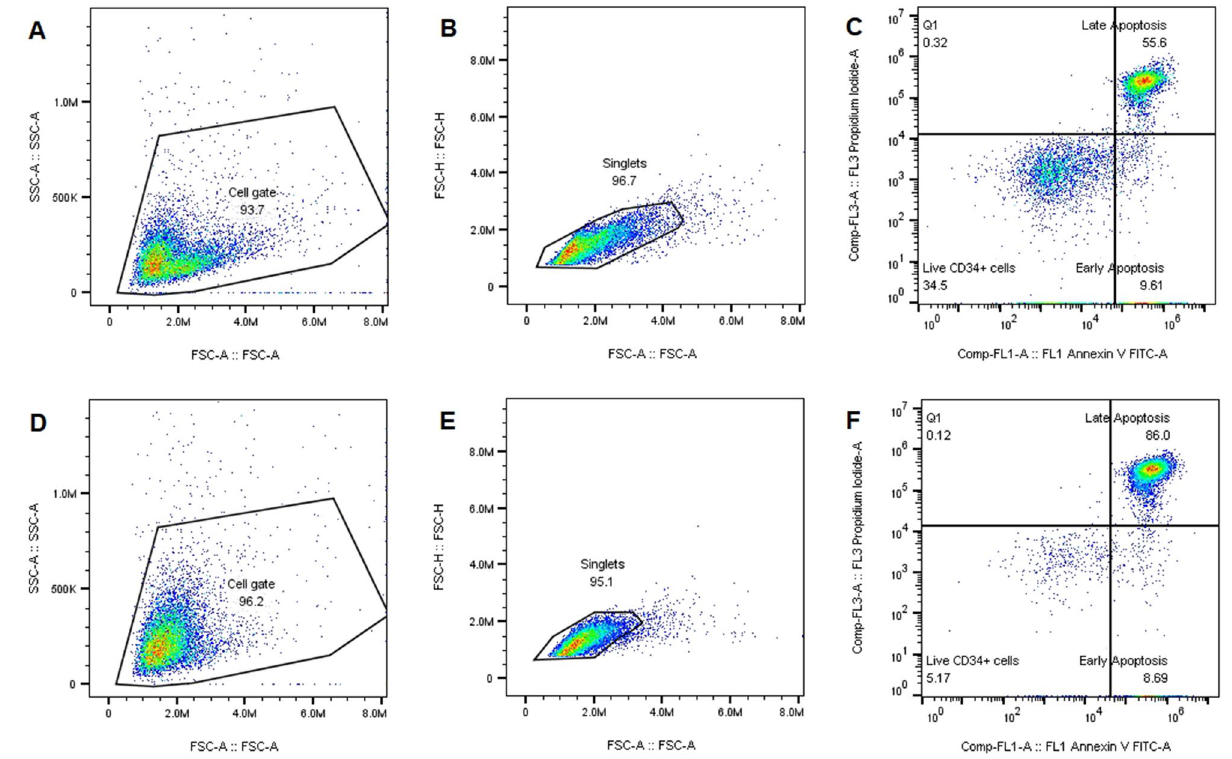
Figure 5. The gating strategy for the Annexin-V/PI apoptosis analysis. CD34 + cells were gated on forward (FSC) versus side scatter (SSC) to select the cell population ( A and D ). Next, the cells were gated on FSC-Height (FSC-H) vs FSC-Area (FSC-A) to exclude all the doublets and to generate the singlets gate ( B and E ). Finally, all the subpopulations were analysed on the Annexin V-FITC versus PI scatter for live, early and late apoptosis at 18 h post-irradiation ( C and F ). The upper part ( A – C ) represents the gating strategy of CD34 + cells irradiated with a low dose of neutrons at 0.5 Gy; and the lower part ( D – F ) CD34 + cells irradiated with a high dose at 3 Gy which resulted in a higher percentage of late apoptosis.